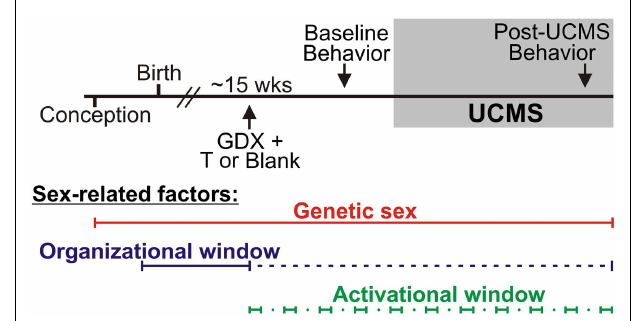
FIGURE 1 | Experimental design and sex-related factors . FCG mice were gonadectomized (GDX) at approximately 15weeks old and implanted with either testosterone (T)-filled or blank capsules. After allowing 3weeks for animals to recover from surgery, all mice were exposed to behavioral tests to assess baseline (“non-stress”) anxiety-like behavior and activity. Mice were then exposed to 7weeks of unpredictable chronic mild stress (UCMS). During weeks 6 and 7 of UCMS, mice were exposed to behavioral tests to assess chronic stress-induced anxiety-like and anhedonia-/depressive-like behavior and activity. Sex-related factors are shown at the bottom to indicate windows of time in which genetic sex, gonadal sex, and/or circulating hormones can act.